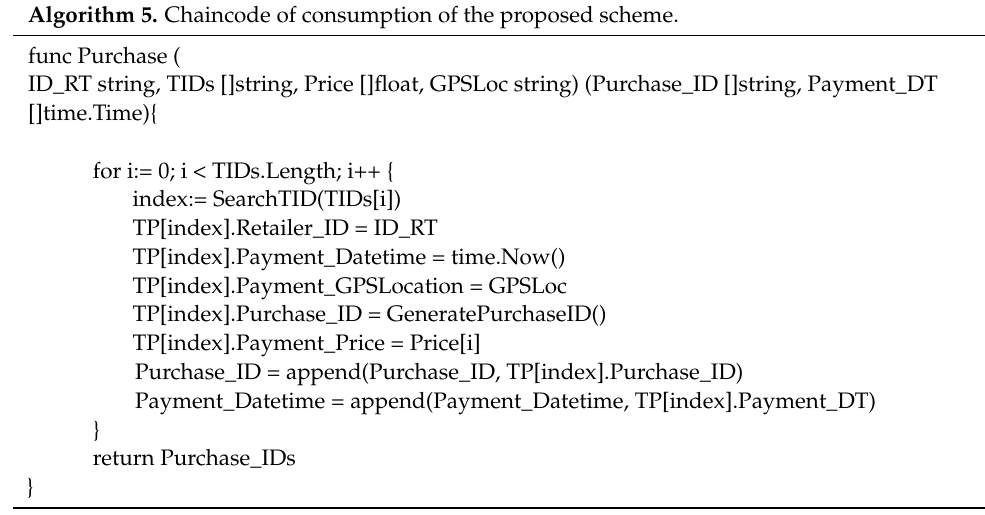
Algorithm 5. Chaincode of consumption of the proposed scheme.